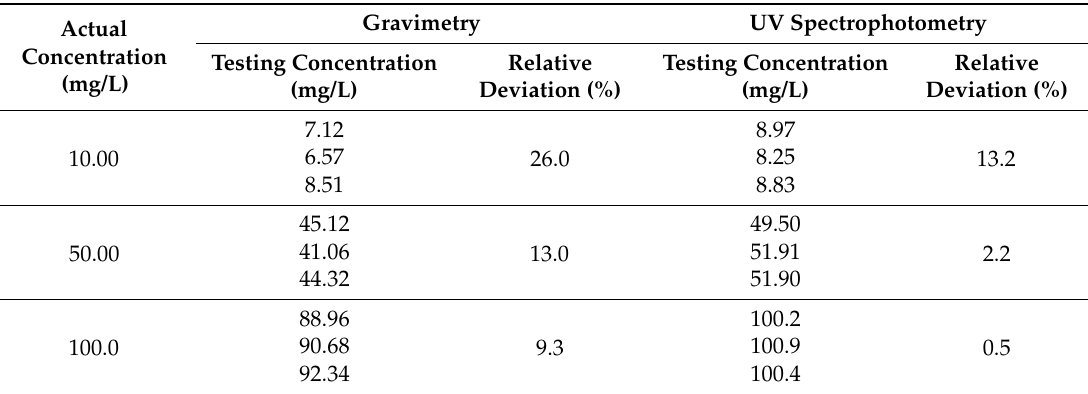
Table 5. Comparison of gravimetry and UV spectrophotometry.